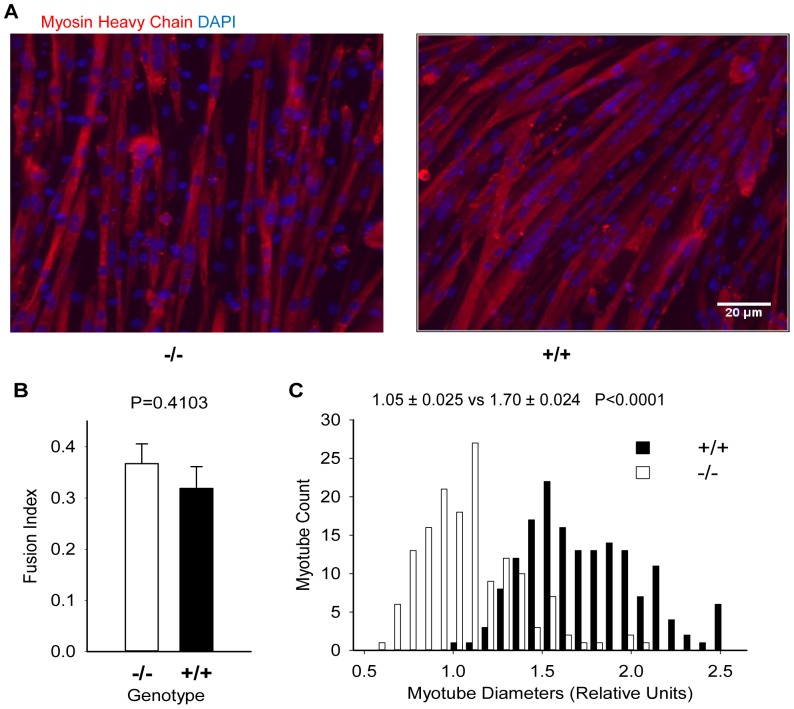
Comparison of myotube size between Park7 (−/−) and Park7 (+/+) genotypes.A: Primary myoblasts were induced to differentiate for 72 hours and stained with an antibody for total myosin heavy chain (red: MF20) and DNA (blue: DAPI). B: No significant differences were detected between the two genotypes for fusion index. C: The distributions of myotube diameters for the two genotypes are shown. The mean diameter for Park7 (+/+; 1.70±0.24) myotubes were significantly larger (P<.0001) than Park7 (−/−; 1.05±0.025) myotubes.